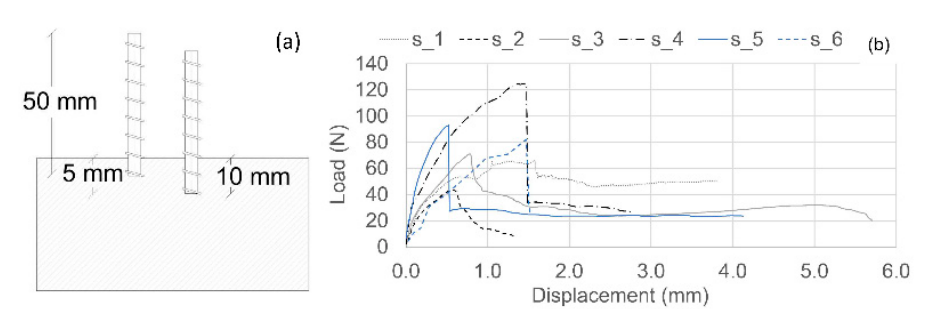
Figure A2 Pull-out test, ( a ) scheme of tubes inserted into mortar specimen; ( b ) representative Load-